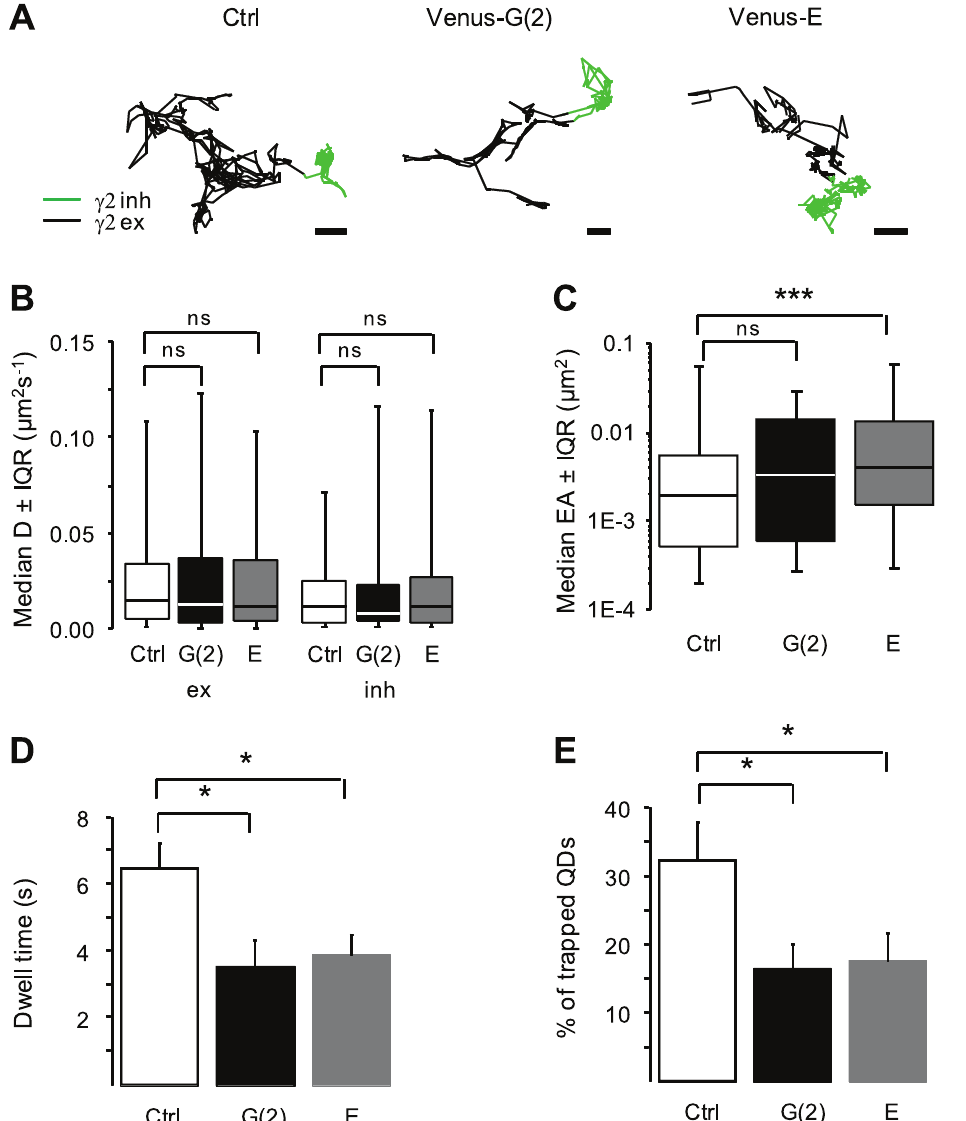
Figure 6. Effects of gephyrin clustering interference on the diffusion properties of the GABA A R c 2 subunit at inhibitory synapses. (A) Individual trajectories of QDs coupled to c 2 outside (black, ex) or inside (green, inh) inhibitory synapses in mRFP-gephyrin knock-in mice neurons transfected with GFP, venus-G(2) or venus-E constructs. Scale, 0.5 m m. (B) Over-expression of the venus-G(2) (black) or venus-E (grey) chimera did not change the diffusion coefficient (median D 6 25%–75% IQR; KS test, ns: not significant) of c 2 outside (ex) or inside (inh) inhibitory synapses as compared to the respective control conditions (GFP, white). In contrast, the gephyrin dominant-negative venus-G(2) (black) and venus-E (grey) constructs increased the explored surface area (C, median EA 6 25%–75% IQR; KS test, ns: not significant, ***: p , 10 2 3 ), and decreased the dwell time (D, mean 6 SEM; t test *: p , 0.05) and the proportion of trapped c 2 (E, mean 6 SEM; t test *: p , 0.05) at inhibitory synapses.